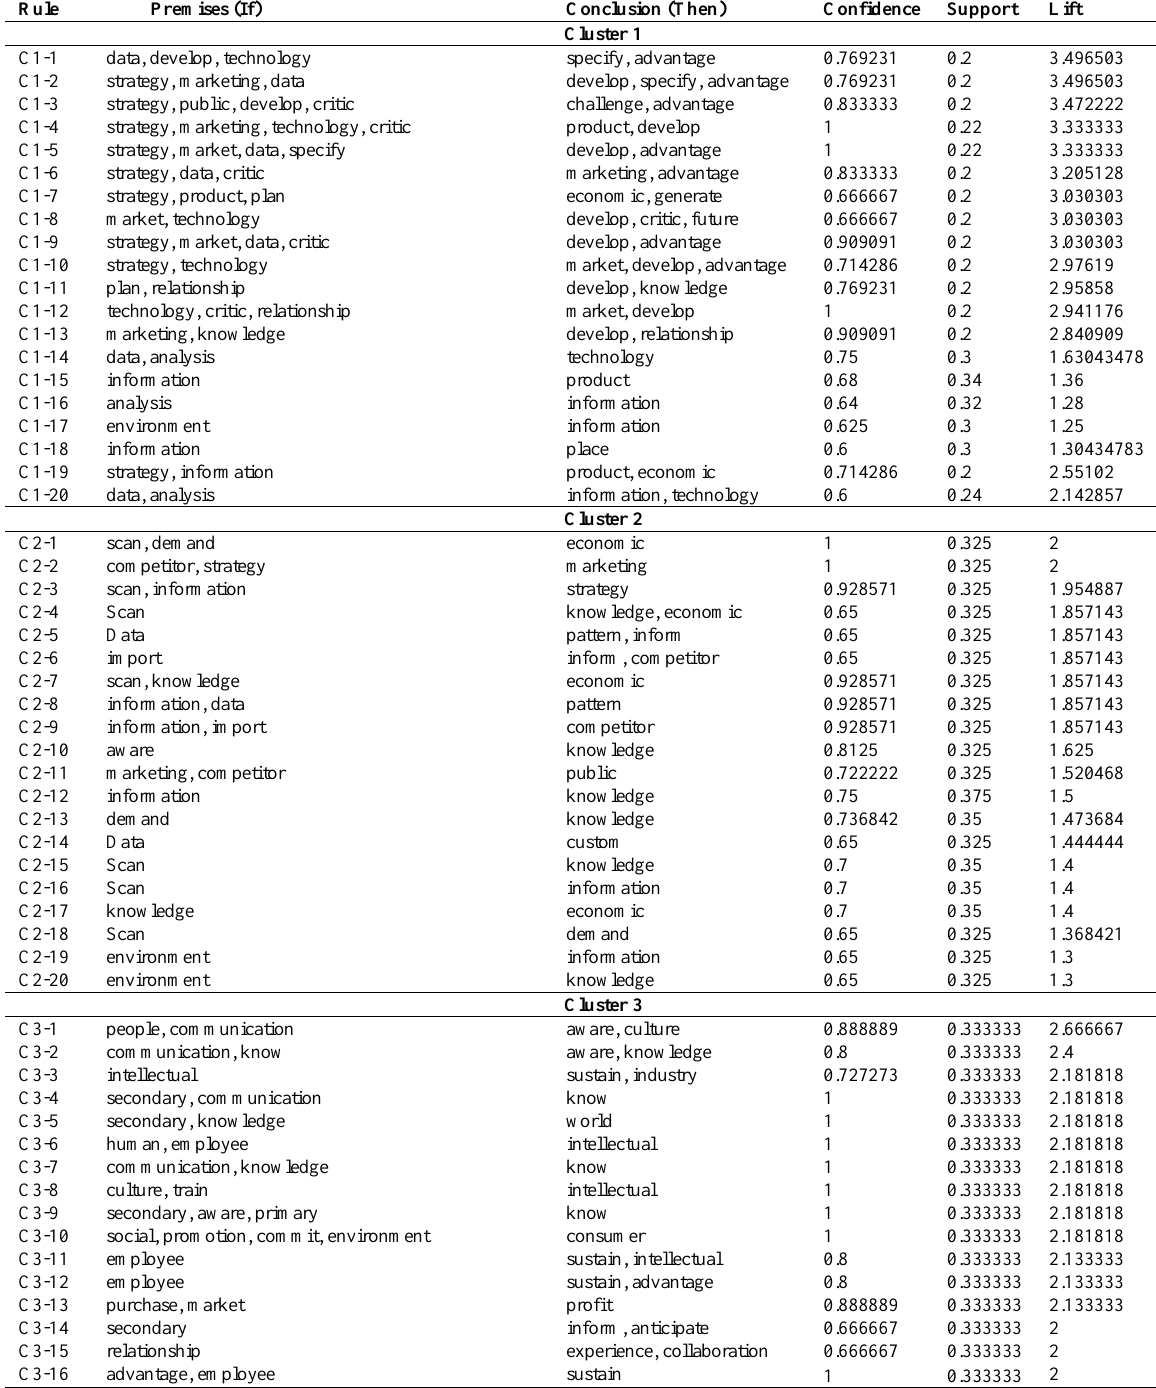
Table 8. Practical and interesting rules for each